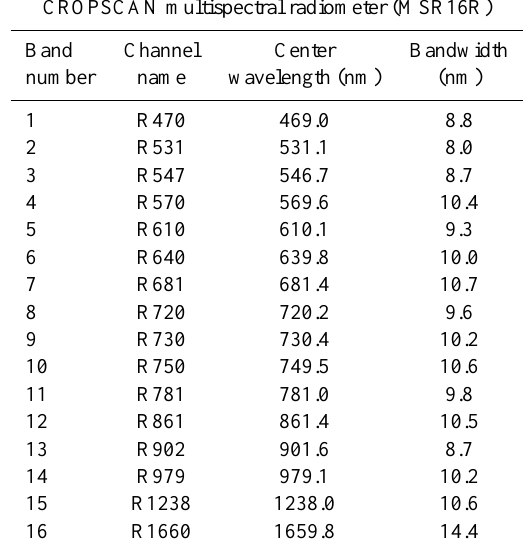
Table 1. Multispectral CROPSCAN MSR16R system specifica-